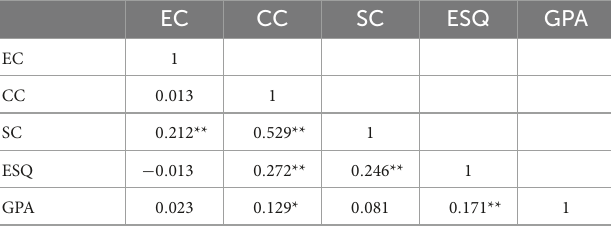
TABLE 1 Correlations among economic (EC), cultural (CC) and social capitals (SC), emo-sensory quotient (ESQ), and grade point average (GPA). EC